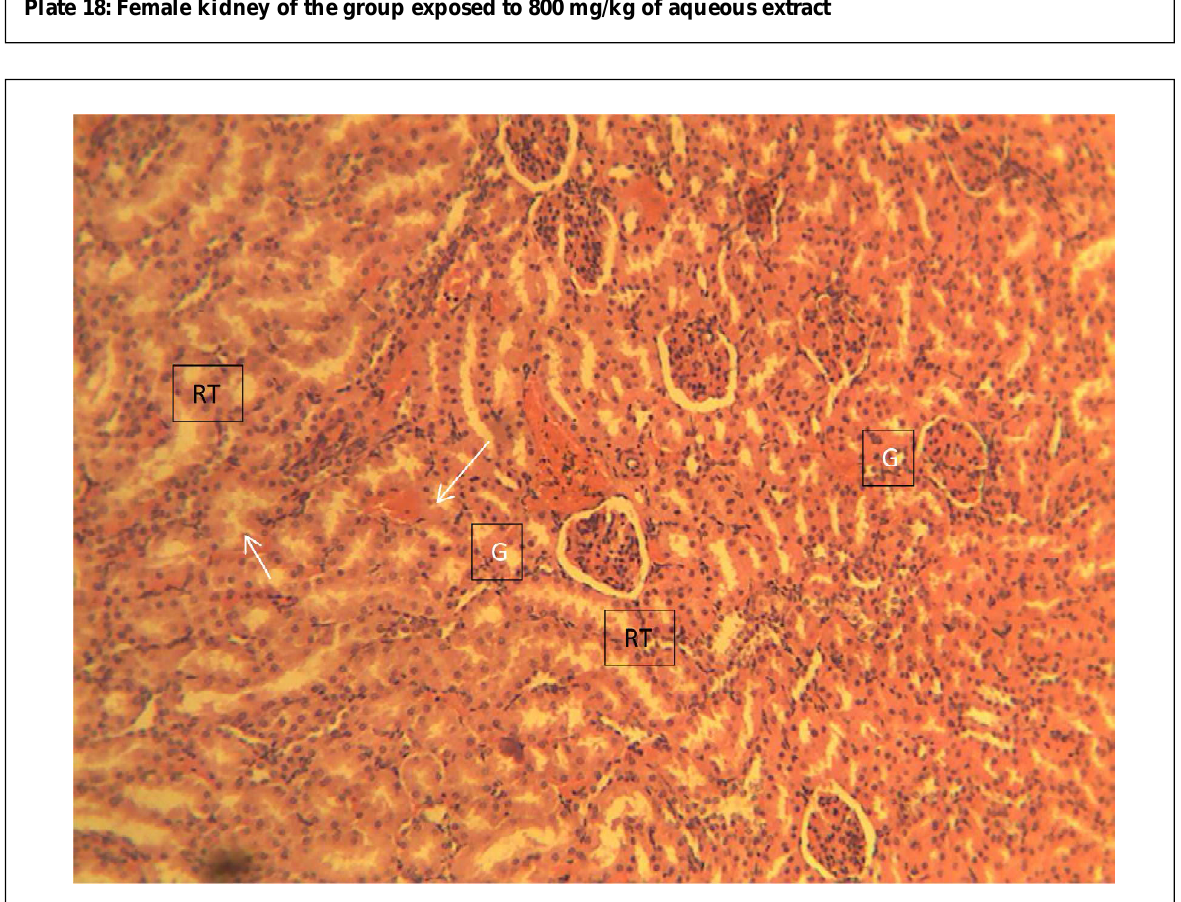
Plate 19: Female kidney of the group exposed to 200 mg/kg of methanol